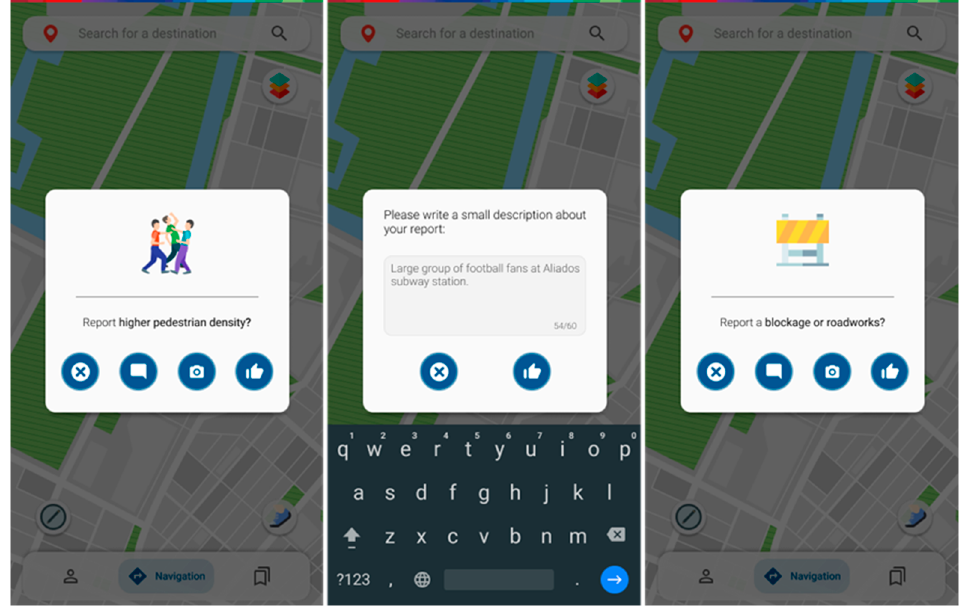
Figure 6. Issue reporting screens.